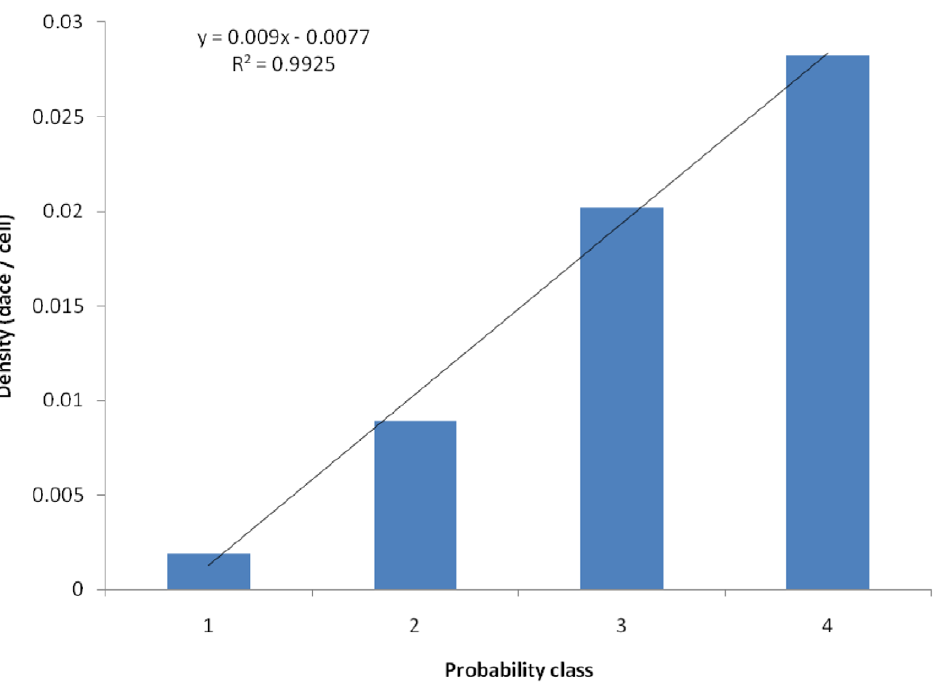
Figure 4. The relationship between Moapa dace density and four probability classes in Plummer Creek, as output by Model 2. Probability classes are 1 (0–20%), 2 (20.1–40%, 3 (40.1–60%), and 4 ( . 60%). Dace densities were obtained by averaging three back-to-back snorkel surveys (spring of 2009), counting the number of dace within each probability class, and dividing by the number of cells (0.0144 m 2 ) found within each probability